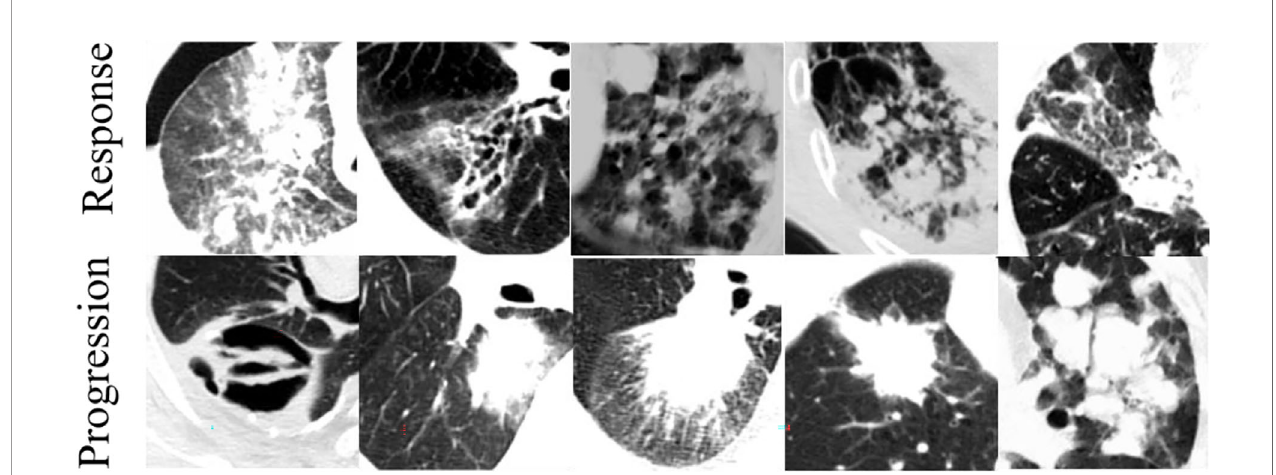
FIGURE 8 | Typical CT images for response and progression